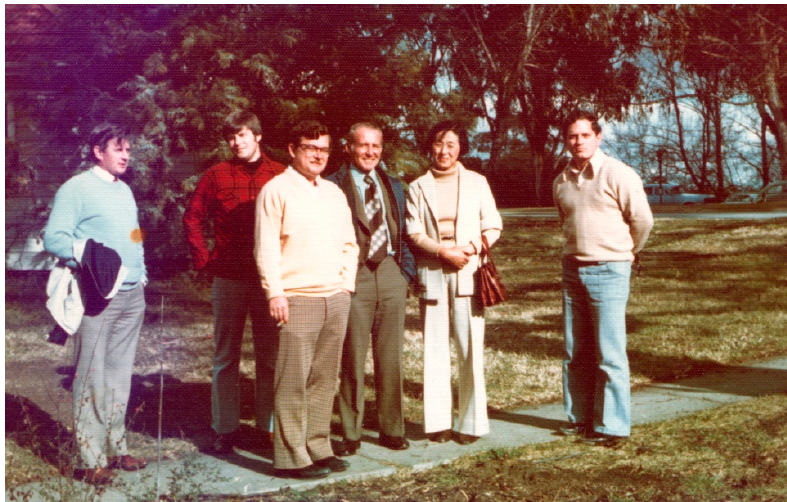
Figure 1. Visit of Professor Syun-iti Akimoto of the University of Tokyo to Research School of Earth Sciences (RSES) in 1975: L to R: David Green, Ted Bence from Stony Brook, Don Anderson from Caltech, Ted Ringwood, Mrs. Akimoto and author.